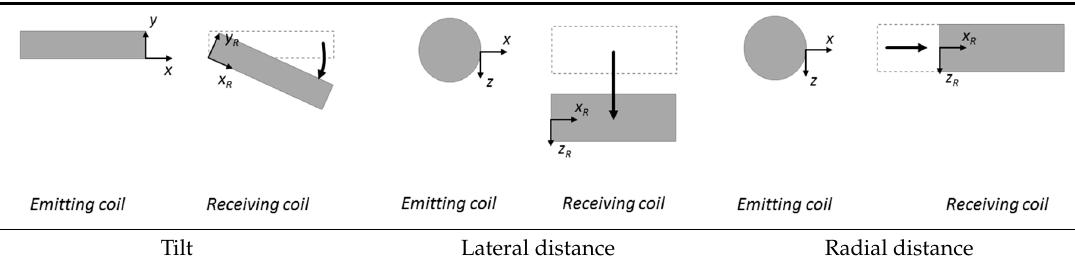
Table 1. Relative coil positions.